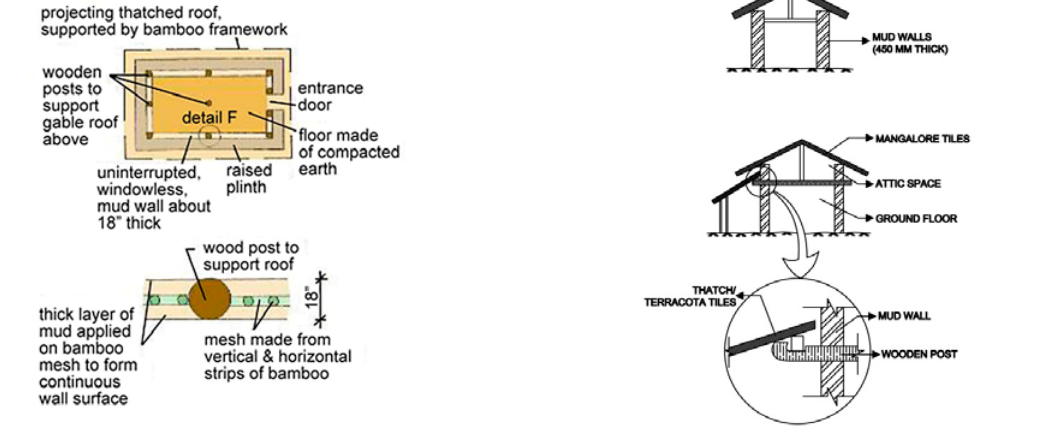
fig. 1. Mud wall with wooden-post of typical hut – plan & detail (reproduced from Dhar 1992)